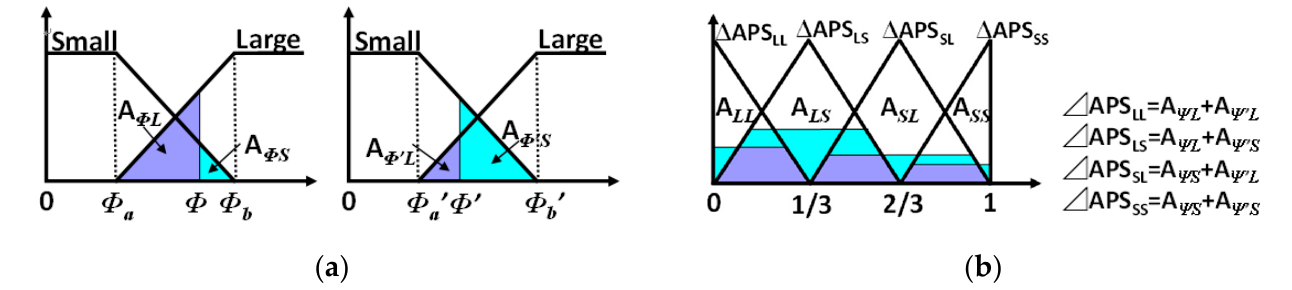
Figure 12. Membership functions for the early stage. ( a ) Input membership function for Φ ; ( b ) output membership function for axial penetration increment ∆ APS .